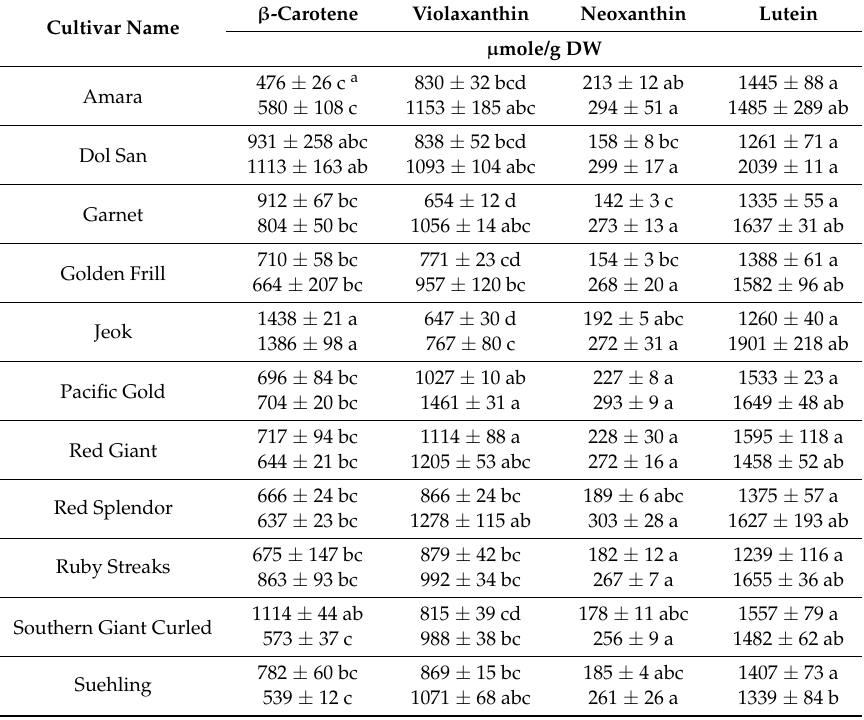
Table 2. Carotenoid concentrations of mustard leaves at baby leaf (upper values in the cells) and mature (bottom values in the cells)